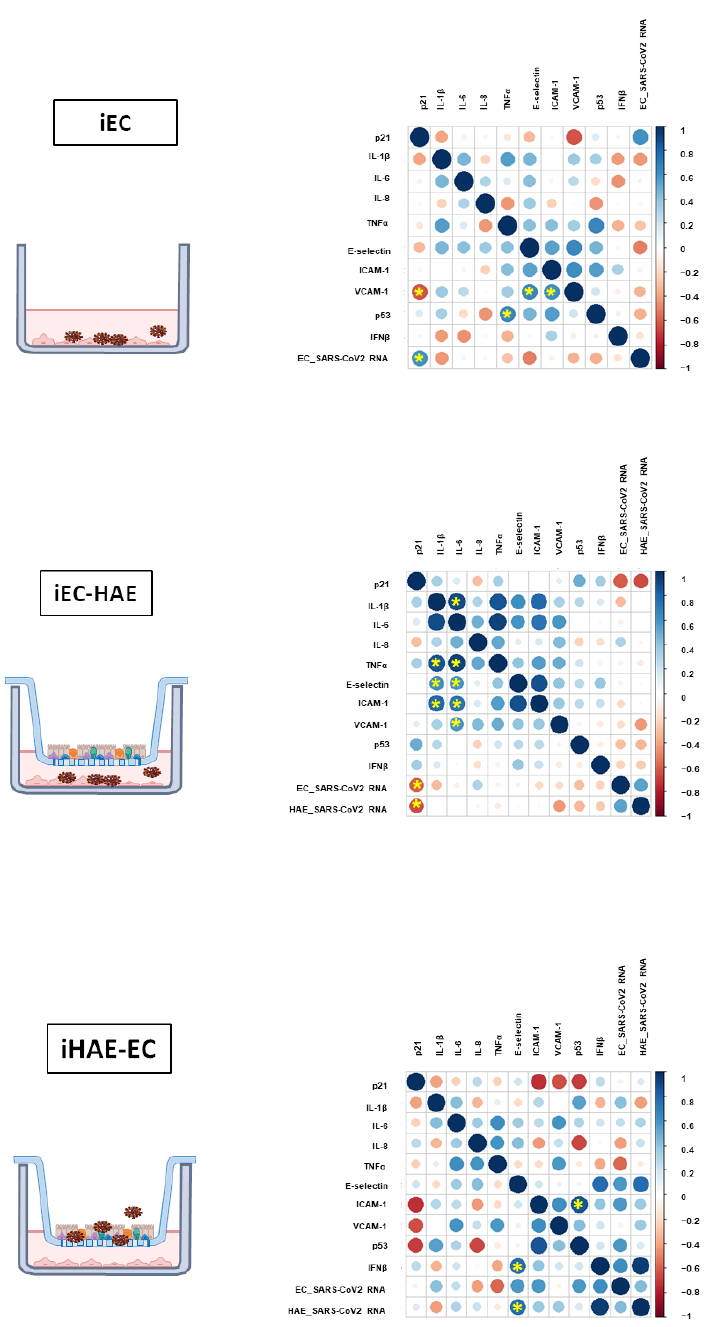
Figure 4. Associations among the inflammatory mediators, IFN- β , SARS-CoV-2 levels, adhesion molecules, and senescence markers expression in ECs cultured alone or with HAE. Spearman correlation matrices among IL-8, IL-1 β , IL-6, and IFN- β levels, ECs E-selectin, ICAM-1, VCAM-1, p21/p53 expression, and SARS-CoV-2 RNA in ECs cultured alone (iEC, upper panel), SARS-CoV-2 infected ECs cultured with HAE (HAE-iEC, middle panel) and SARS-CoV-2 infected HAE cultured with EC (iHAE-EC, lower panel). The significant correlations (<0.05) are indicated with an asterisk. The correlations between EC activation and the other parameters have been